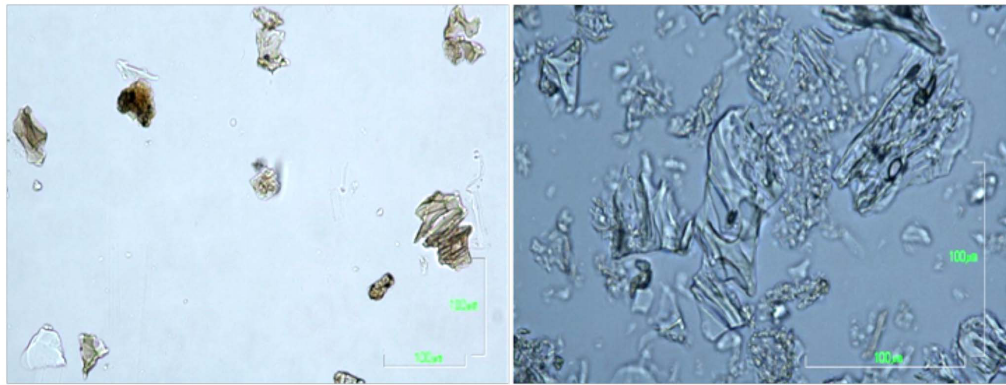
Figure 5. Picture of Mt. Hudson 5745–5327 yrs cal BC (428 cm depth, left) and Mt. Burney 2354–2130 yrs cal BC (347 cm depth right) shards found in Karukinka peat